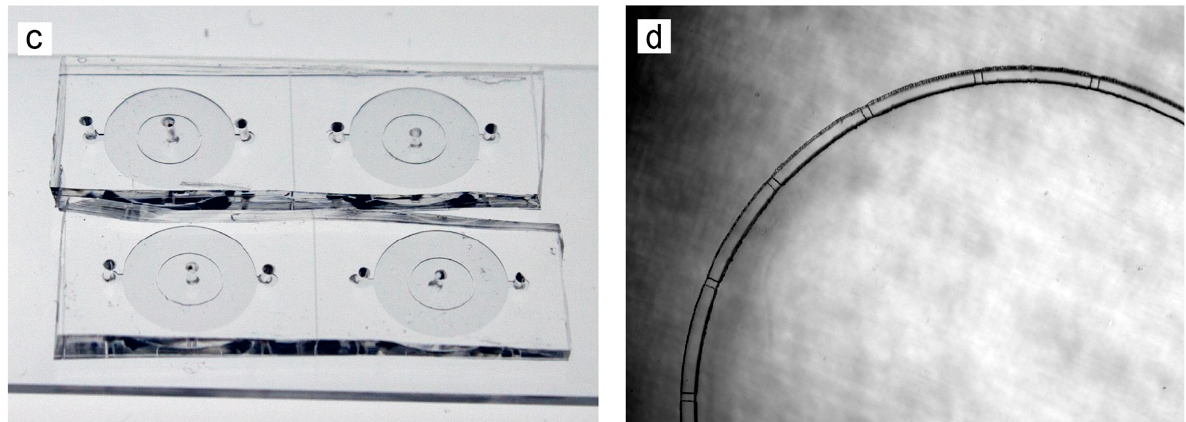
Figure 4. Neuronal chemotaxis device. ( a ) Multilayer master mold, following the final hard bake. ( b ) Microscope image of master mold. Cell migration channels traverse a wall separating the culture chambers. ( c ) Completed devices after molding PDMS, forming ports with a biopsy punch, and plasma bonding to a glass slide. ( d ) Microscope image of PDMS device, showing cell migration channels connecting the inner and outer cell culture chambers.